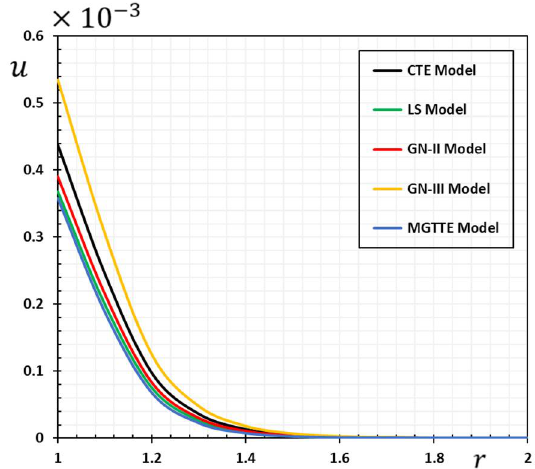
Figure 10. The displacement, u , versus different thermoelastic models.